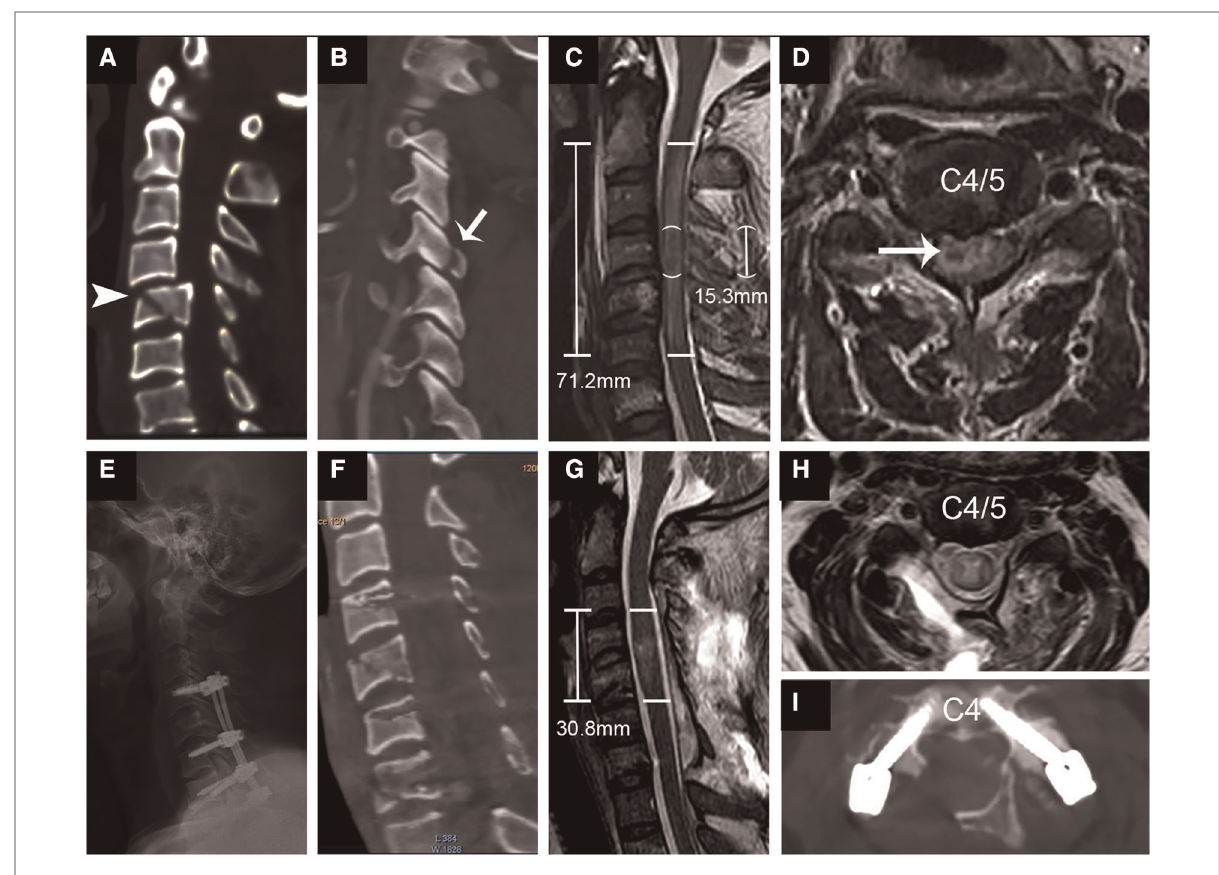
FIGURE 3 Representational preoperative ( A – D ) and postoperative ( E – I ) images of a 44-year-old male patient who sustained a C type fracture and spinal cord injury. His AMS was 3 and AIS grade A. Sagittal subaxial CT indicated C4 translation rotation injury ( A ) accompanied by fracture of the right inferior articular process ( B , short arrow) and C5 teardrop fracture (arrowhead). MRI ( C,D ) showed SCI with an IMLL of 71.2 mm and intramedullary hemorrhage (long arrow) 15.3 mm in length. The subarachnoid space (SAS) was absent from C3 to C5 ( C ). Laminoplasty of C3 – 7 and pedicle screw fi xation from C4 – C7 were performed in this patient 14 h after trauma. Postoperative x-rays ( E ) and CT ( F,I ) showed good screw positioning and signi fi cant enlargement of the osseous spinal canal. Postoperative MRI indicated an IMLL of 30.8 mm ( G ) and successful decompression ( G,H ) 12 days after trauma. One year after injury, the patient paralysis recovery with an AMS of 58 and AIS grade C